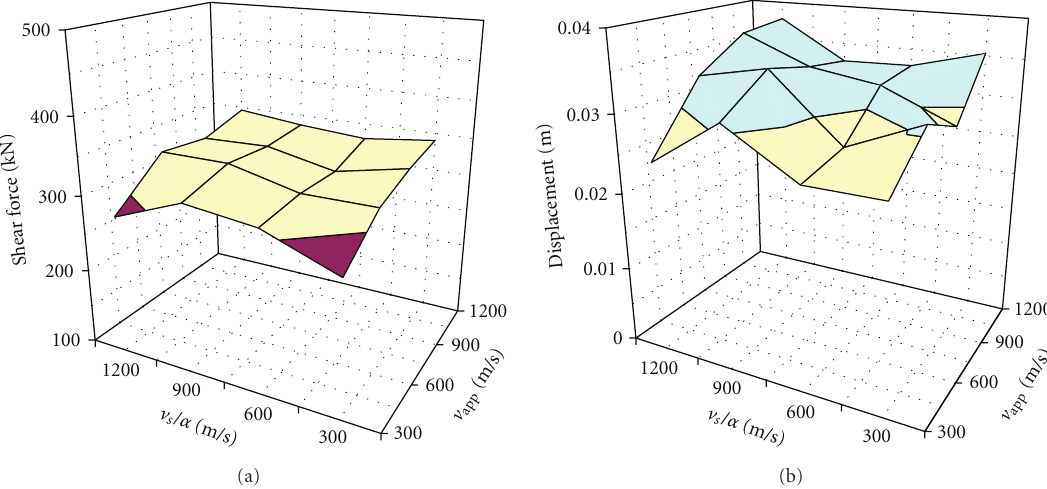
Figure 15: Longitudinal direction: (a) shear forces at the pier base: maximum values obtained for each correlation level of input ground motions; (b) maxima values of displacement at pier top.